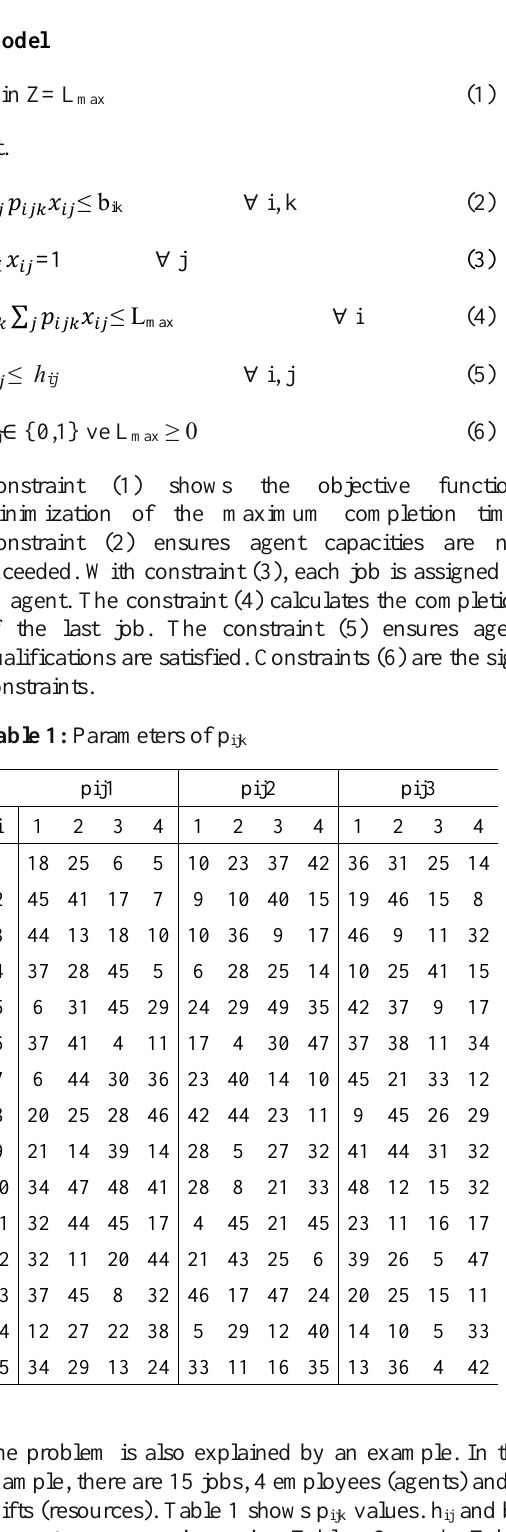
Table 2: Parameters of h ij